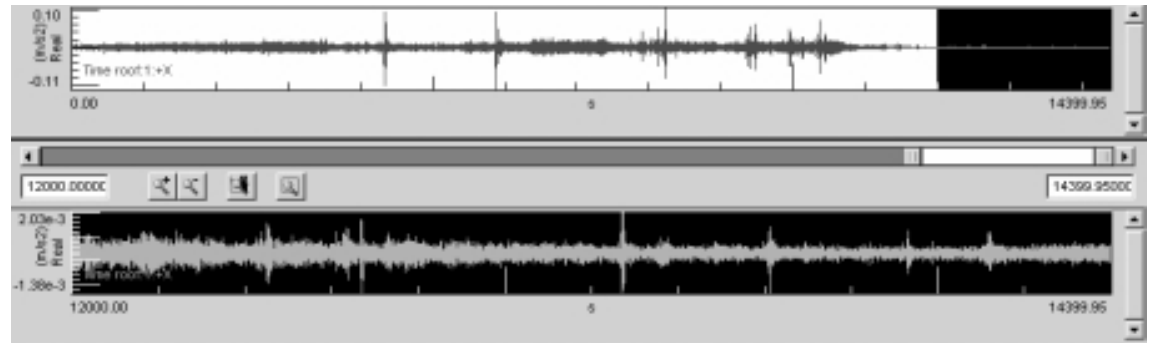
Fig. 2. Stadium ambient acceleration time data. (Top) 4 hours recording; (Bottom) selection of the last 2400 s for further processing.